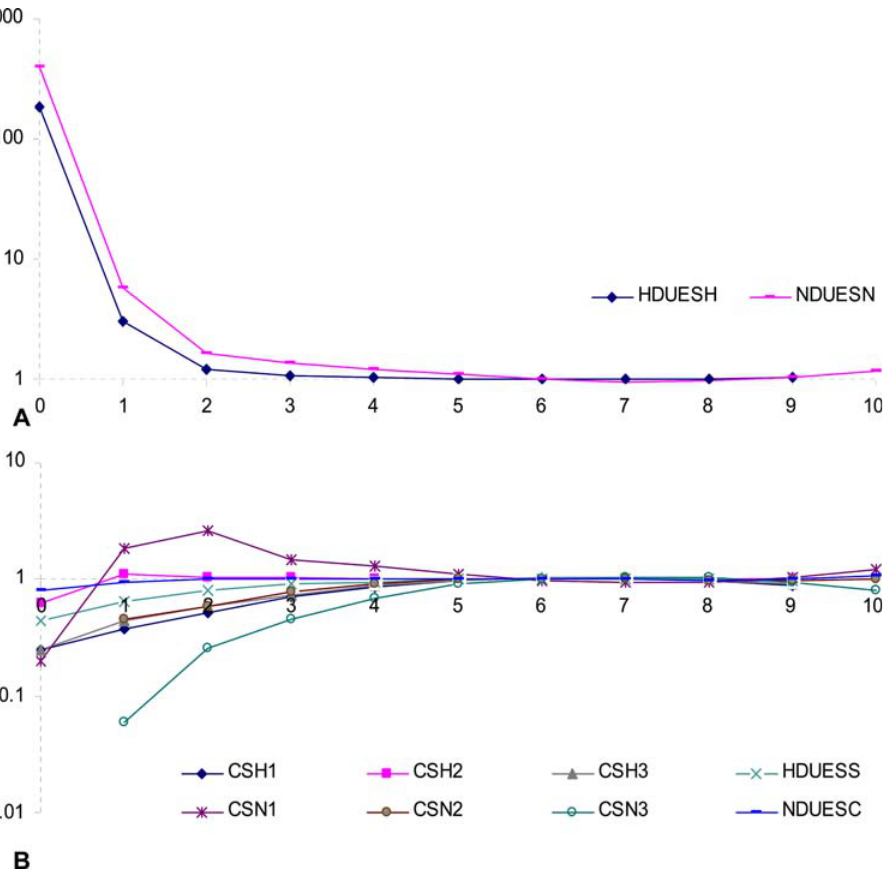
Figure 1. Ratio of the observed to the expected number of sequences across mismatch loads. X-axis: Mismatch load. A : DUESs. B : Control sequences. HDUESH and HDUESS refer to H. influenzae DUES in H. influenzae and S. pyogenes genomes, respectively. NDUESN and NDUESC refer to N. gonorrhoeae DUES in N. gonorrhoeae and C. tepidum genomes. CSH1, 2, and 3 and CSN1, 2, and 3 refer to the three control sequences in H. influenzae and N. gonorrhoeae (see Material and methods). doi:10.1371/journal.pone.0000741.g001 the two major drops in sequence overrepresentation reported sequence frequencies in a population of 10 18 genomes with the above reflect uptake bias only towards sequences with less than 2 same distribution of sequence frequencies as those expected for mismatches to the DUES. I therefore simulated the evolution of randomized H. influenzae and N. gonorrhoeae genomes (see Table S1) Table 1. Sequence representation (equation 2) of DUESs, control sequences, and all their mismatched forms. .. ... .... ... ... .... ... ... .... ... ... .... ... ... .... ... ... .... ... ... .... ... ... .... ... ... .... ... ... .... ... ... .... ... ... .... ... ... .... ... ... .... ... ... . Mismatch load H.influenzae